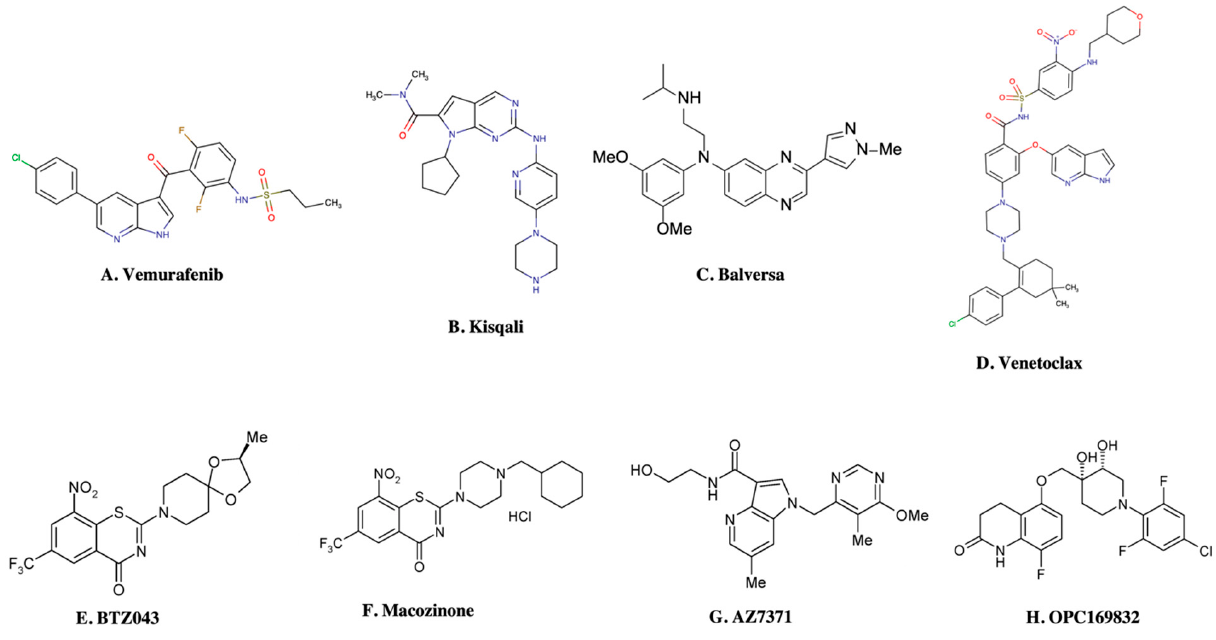
Figure 1. FBDD inhibitors in clinical trials for cancer ( A – D ) and TB ( E – H ).